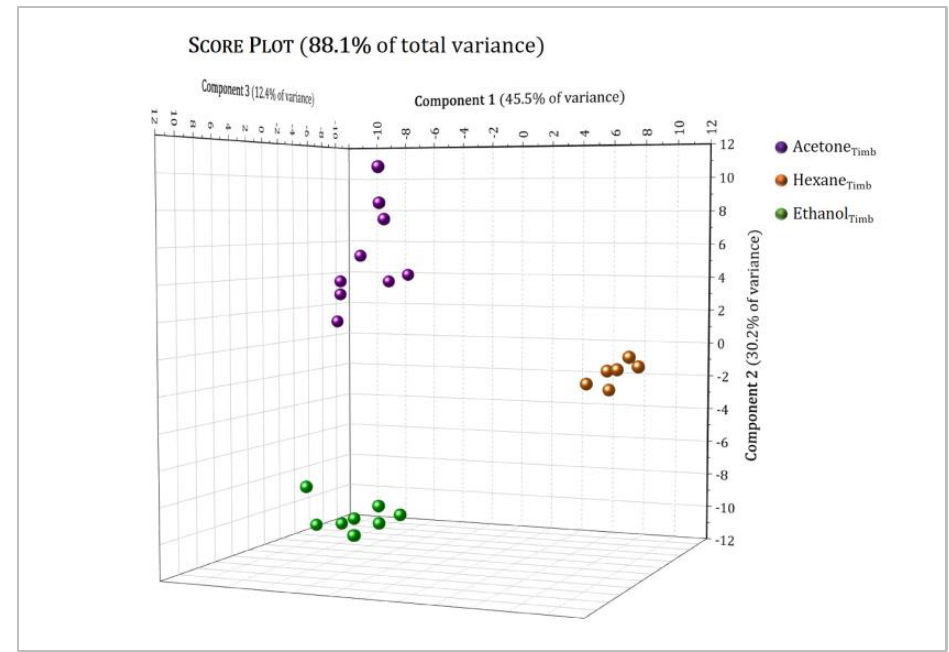
Figure 9. Principal component analysis (PCA) of hexane (brown dots), acetone (purple dots) and ethanol (green dots) extracts of the Tiborszallasi variety of hemp. The score plot shows the first three PCs (PC1, PC2 and PC3) with their respective variations. R2X(PC1) = 45.5%, R2X(PC2) = 30.2%, R2X(PC3) = 12.4%.